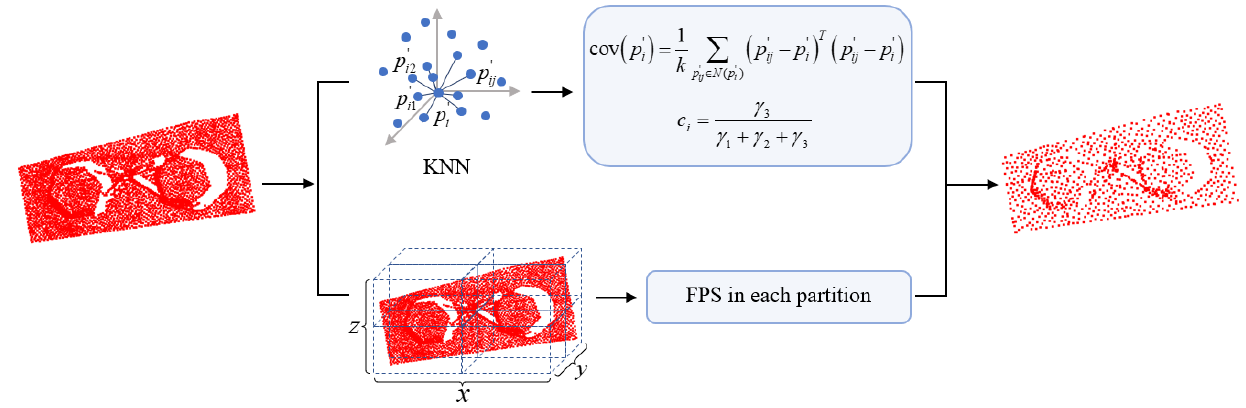
Figure 4. The pipeline of the FFPS-kp.